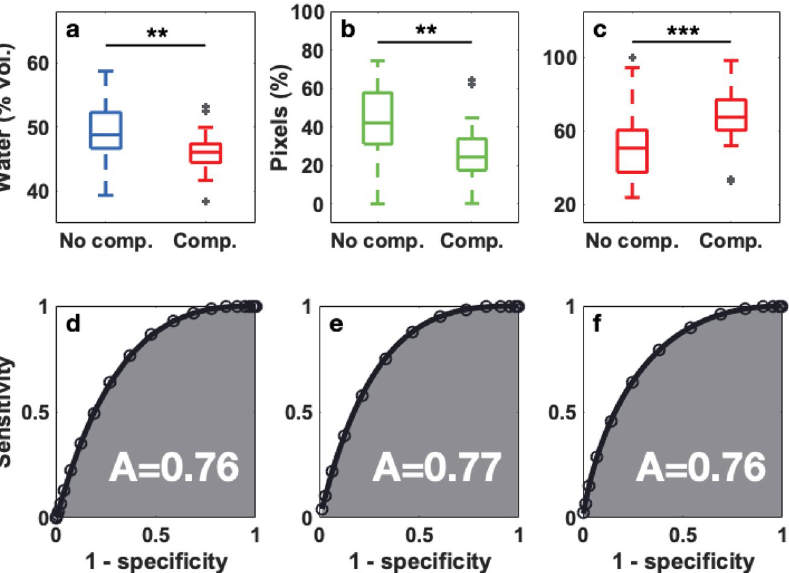
Figure 6. ( a ) Hydration averaged over the foot sole ( p = 0.0016 ), ( b ) green pixels distribution ( p = 0.0011 ) and ( c ) red pixels distribution ( p = 0.0010 ) of diabetic patients with no complications ( n = 45 ) and diabetic patients with complications ( n = 21 ). Diabetic patients with complications present the less hydration and green pixels and the more red pixels which indicates higher skin deterioration. The ( d – f ) ROC curves represent the ability to discriminate between both groups according to ( a – c ), respectively.